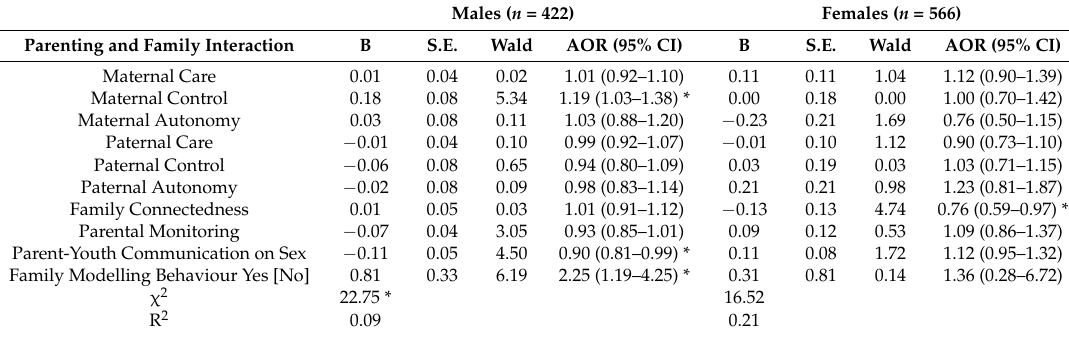
Table 3. Logistic regression of family interactions and parenting variables on youth sexual intention for male and female youths. Males ( n = 422) Females ( n =